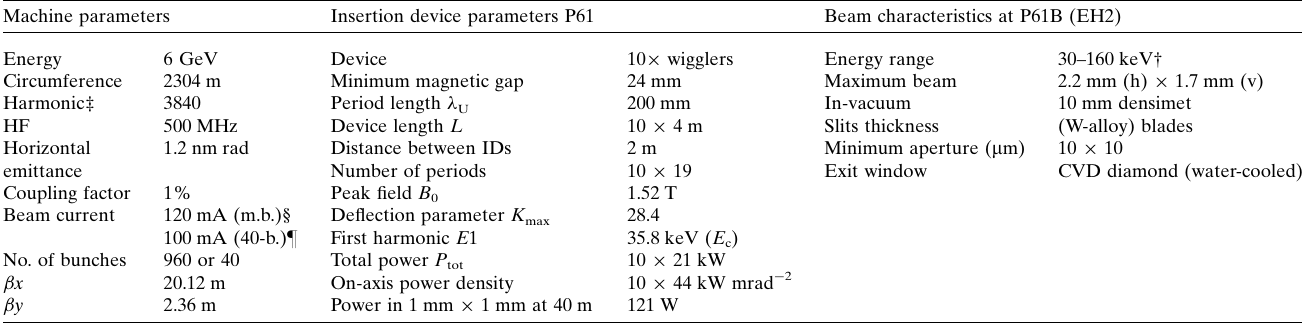
Table 1 Machine parameters of the PETRA III storage ring, including extensions (Bacher et al. , 2007) and the parameters of the ten damping wigglers (Drube et al. ,